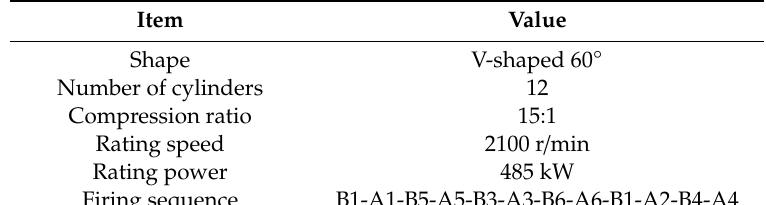
Table 1. The key parameters of the diesel engine.